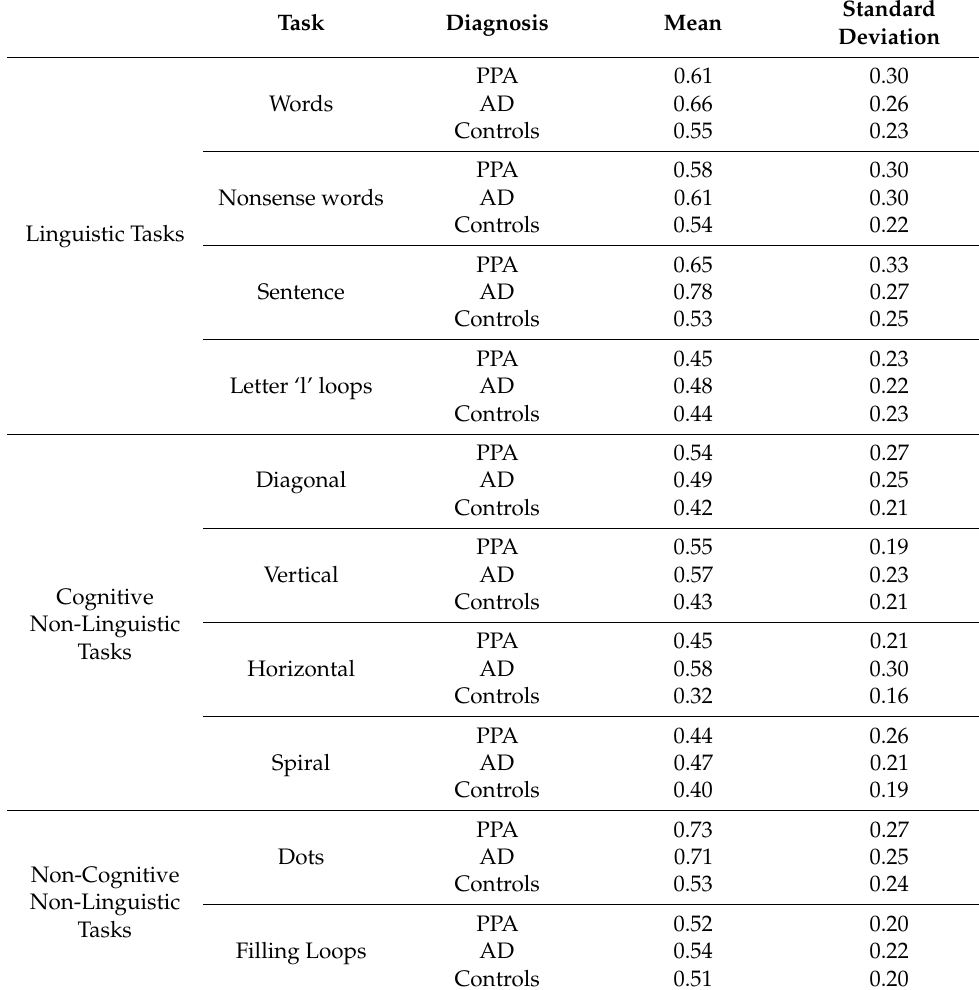
Table 3. Maximum writing pressure in participants with PPA, AD and Healthy Controls. Task Diagnosis Mean